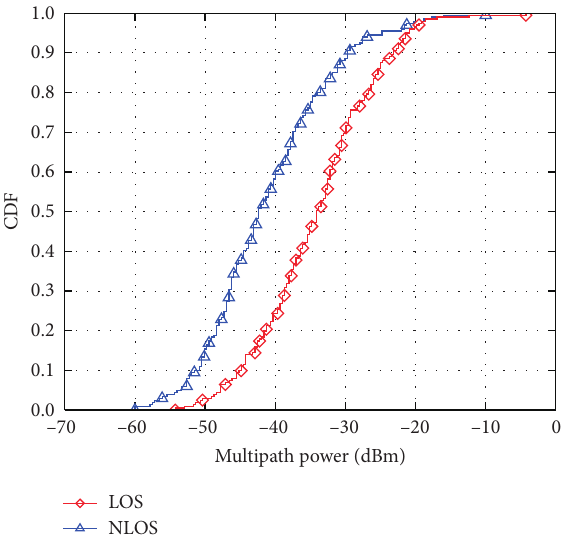
Figure 8: Multipath power in the normalized